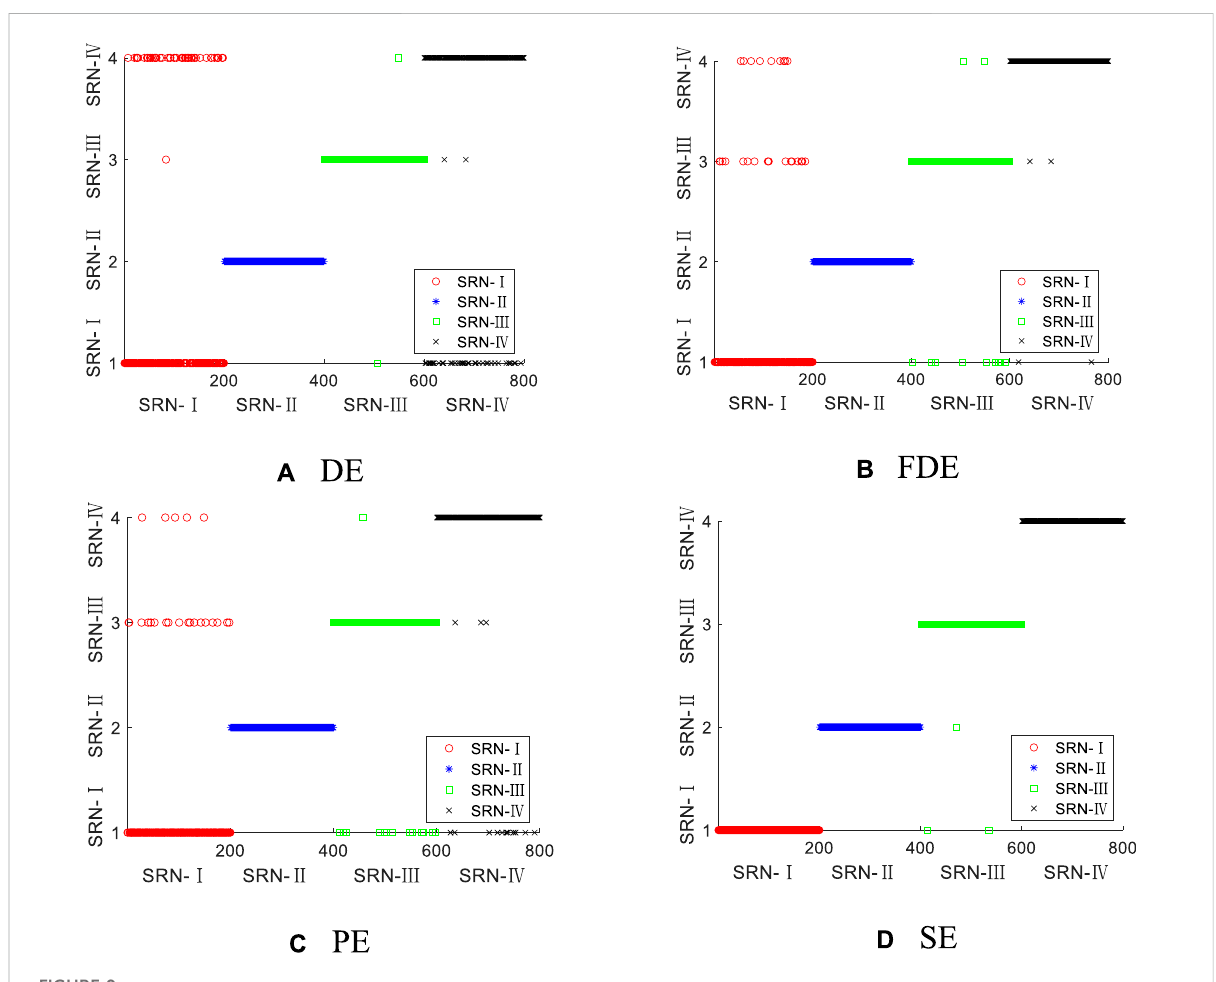
FIGURE 9 Dual feature classi fi cation results of four types of entropy for four types of SRN. (A) DE (B) FDE (C) PE (D)